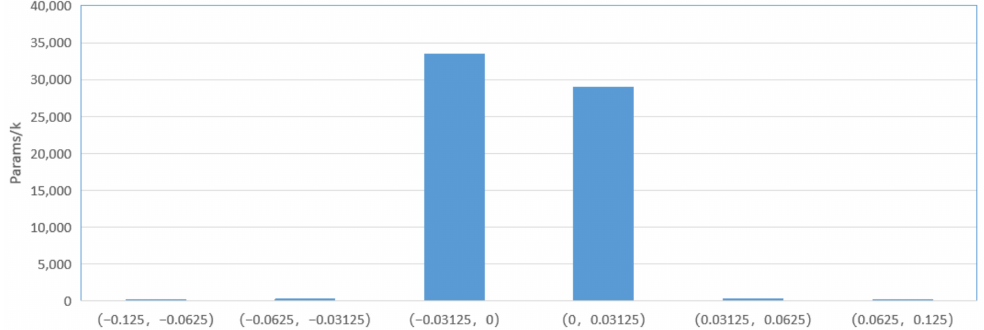
Figure 7. Histogram of weight distribution.